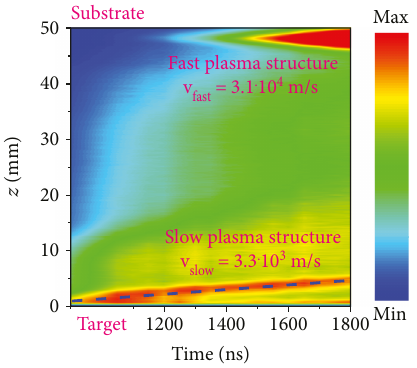
Figure 5: Excimer laser-produced carbon plasma expansion in vacuum: space-time contour plot of emission intensity along the z -axis (LP=46 cm, 2.1 J/cm 2 fl